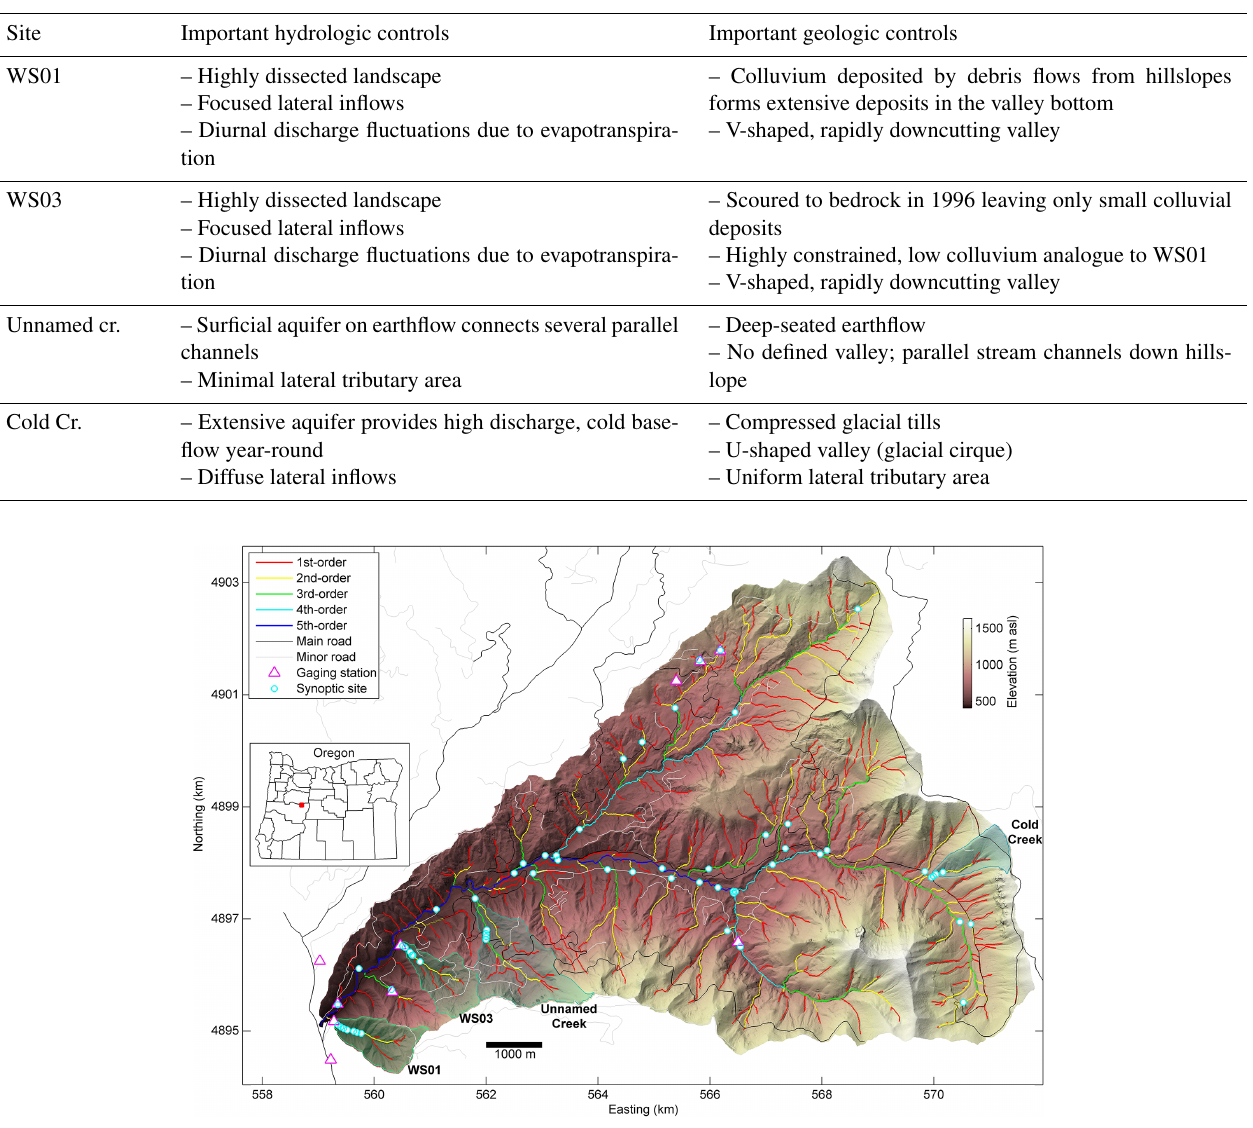
Table 1. Summary of key characteristics of the fixed-reach sites. See detailed descriptions for further information (Dyrness, 1969; Swanson and James, 1975; Swanson and Jones, 2002; Jefferson et al., 2004; Cashman et al., 2009; Deligne et al., 2017).